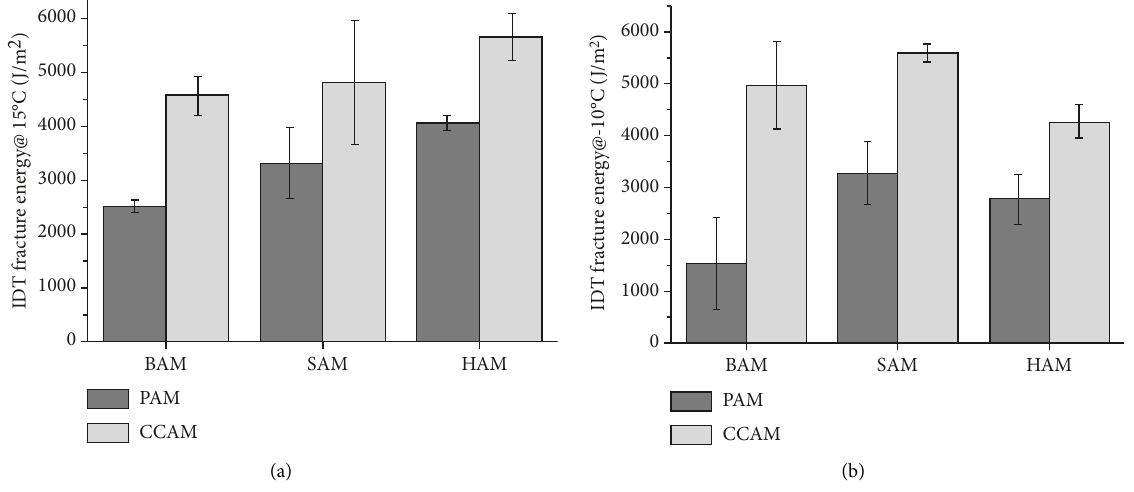
Figure 11: IDT fracture energy of PAM and CCAM samples. (a) 15 ° C. (b) − 10 °